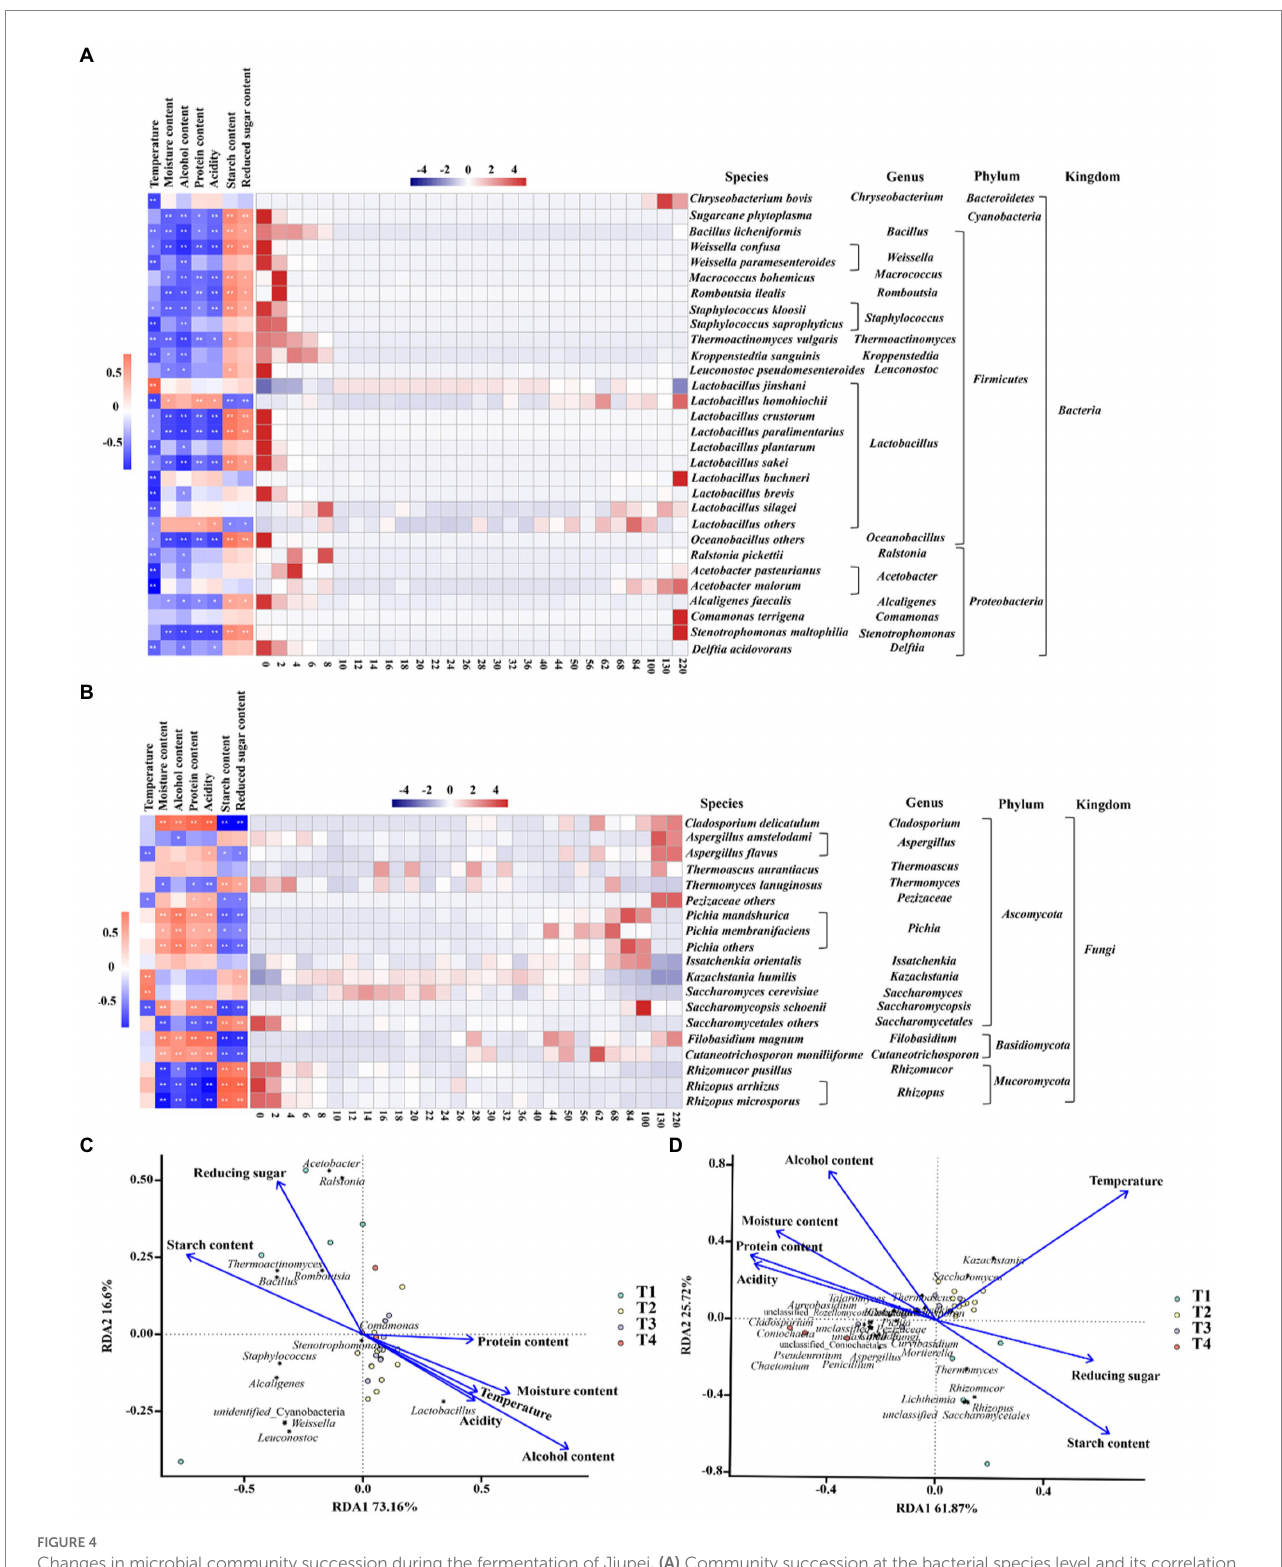
FIGURE 4 Changes in microbial community succession during the fermentation of Jiupei . (A) Community succession at the bacterial species level and its correlation with physicochemical parameters. (B) Community succession at the fungal species level and its correlation with physicochemical parameters. (C) The driving force in the fermentation process of bacterial of Jiupei. (D) The driving force in the fermentation process of fungal of